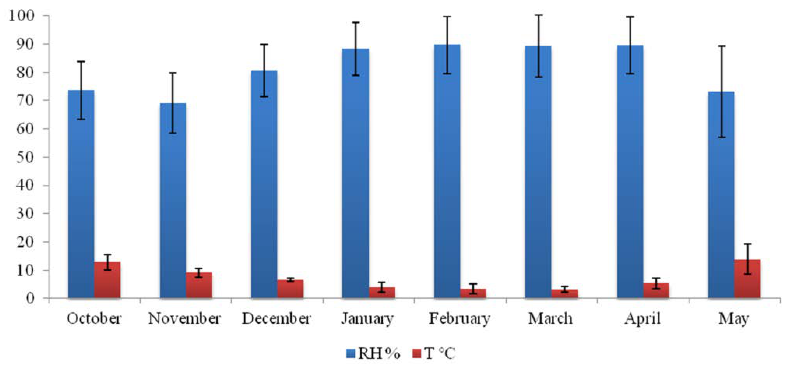
Figure 3. Relative humidity (RH%) and temperature (°C) fluctuations within Cave Church of Sts. Peter and Paul.